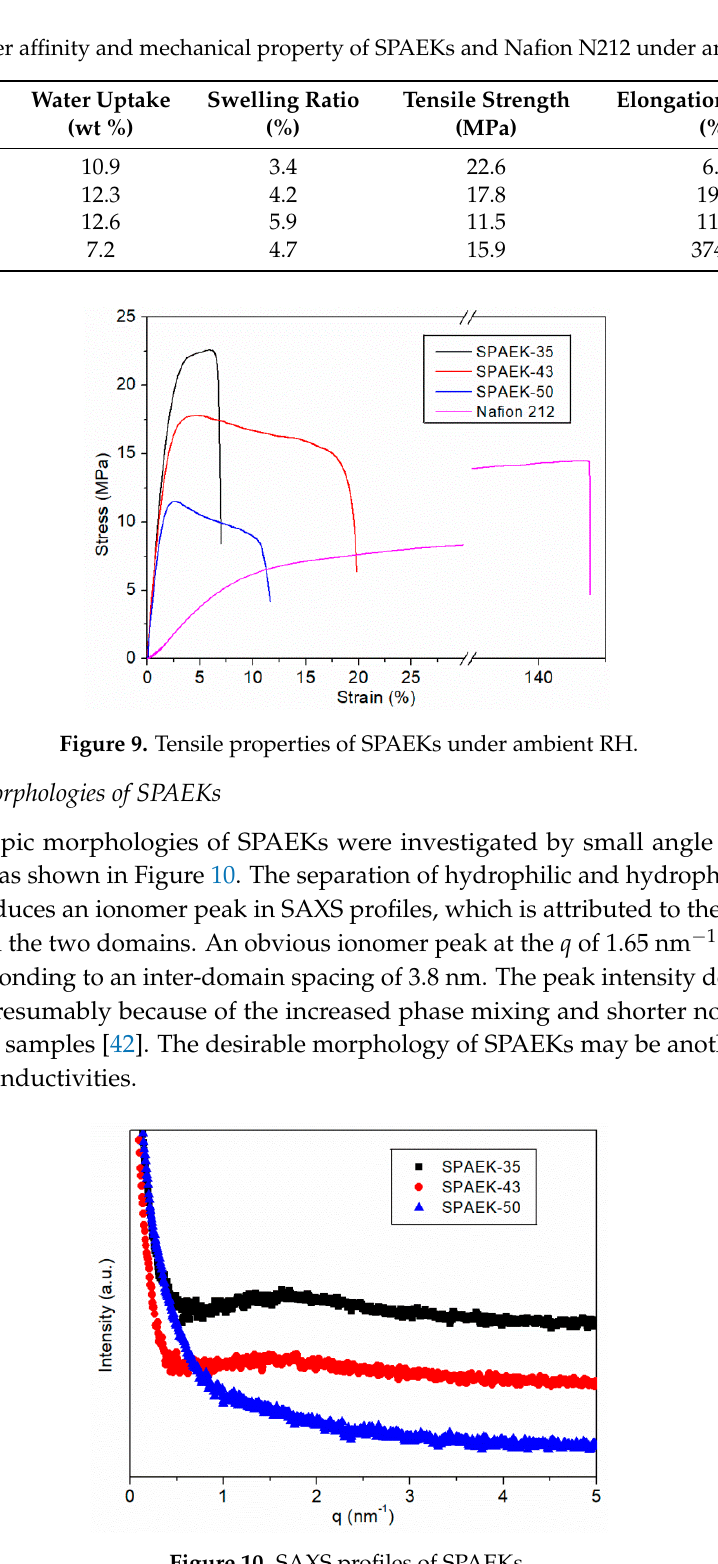
Figure 10. SAXS profiles of SPAEKs.